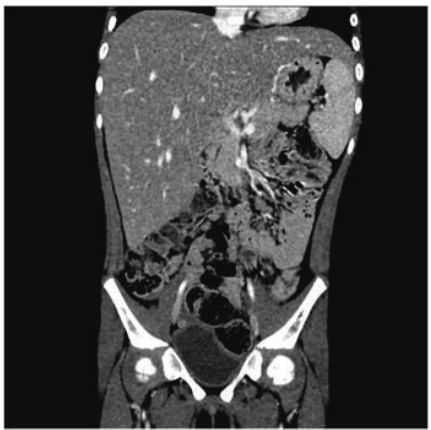
Figure 1: Computed tomography of abdomen and pelvis. The liver is enlarged, measuring up to 17 cm in width and craniocaudal dimension. The contour is smooth. The hepatic parenchyma is homogenous without a focal mass. There is no intrahepatic biliary dilatation. The portal and hepatic venous systems are patent and nondilated.